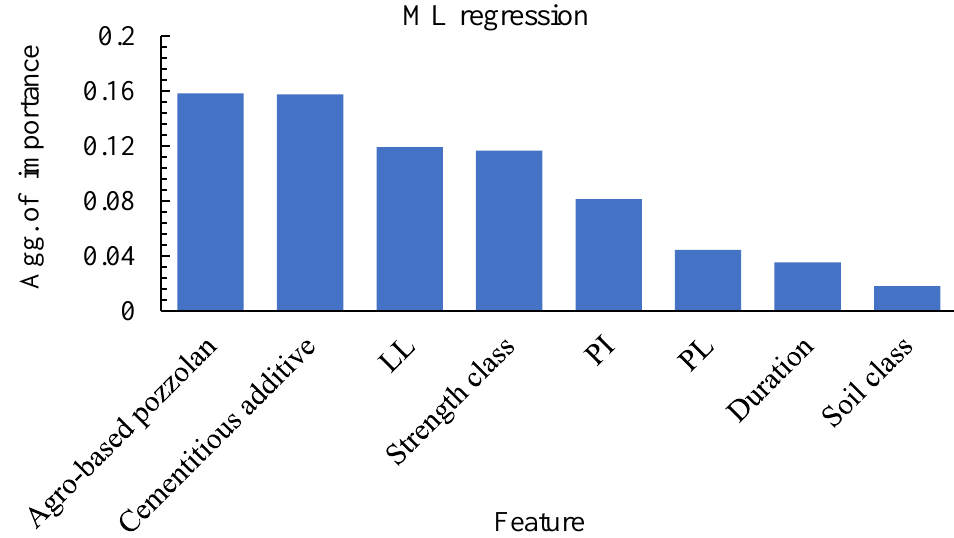
Figure 11. Regression aggregate feature importance.